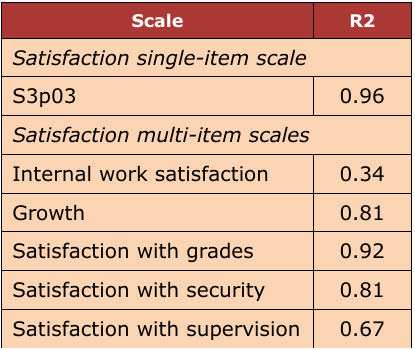
Table 10. Single and multi-item satisfaction scales R